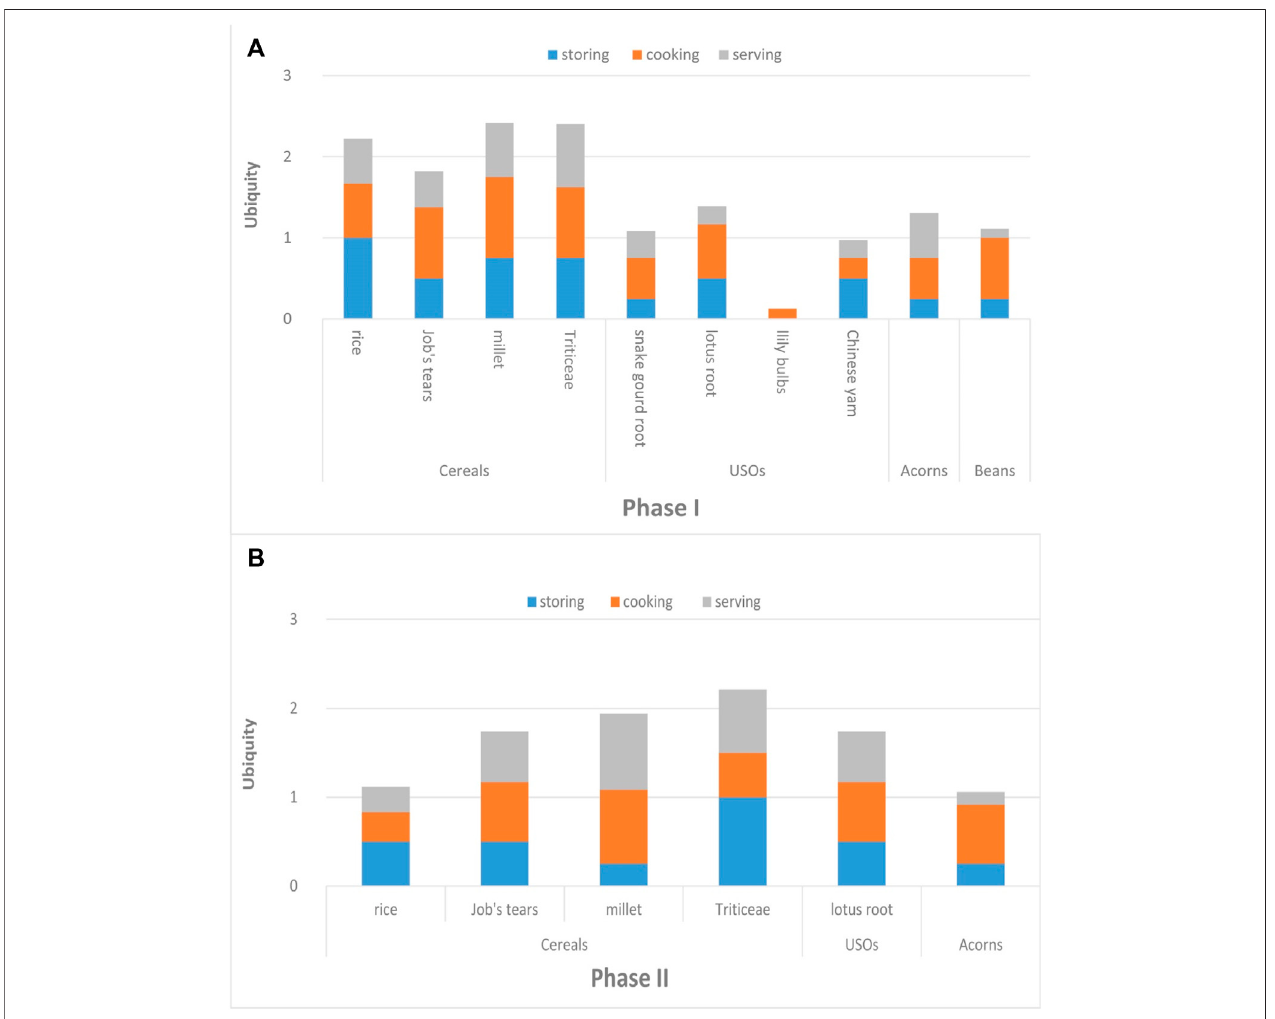
FIGURE 6 | (A) Ubiquities of different types of starch grains on Houjiazhai pottery vessels attributed to Phase I; (B) ubiquities of different types of starch grains on Houjiazhai pottery vessels attributed to the Phase II (note: ubiquity refers to the occurrence of identi fi ed plant taxa amongst the certain type of pottery vessels: storing, cooking, and serving, see also the Supplementary Tables S3, S4